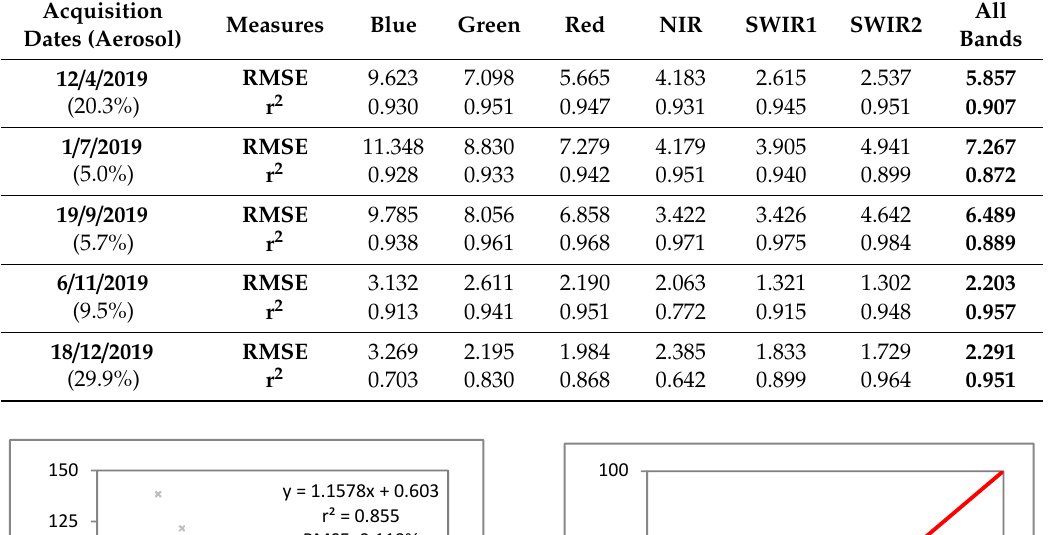
Table 5. Band-by-band RMSE (% reflectance units) and coefficient of determination (r 2 ) between simultaneous S2 L2A and L8 L2 official products considered in SS4 (Antalya). The percentage of high- level aerosol (SR aerosol) on the SS4 for each date is shown in the first column between brackets. Acquisition